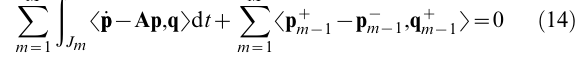
Algorithm 1. Assemble Projected CME Operator in QTT Matrix